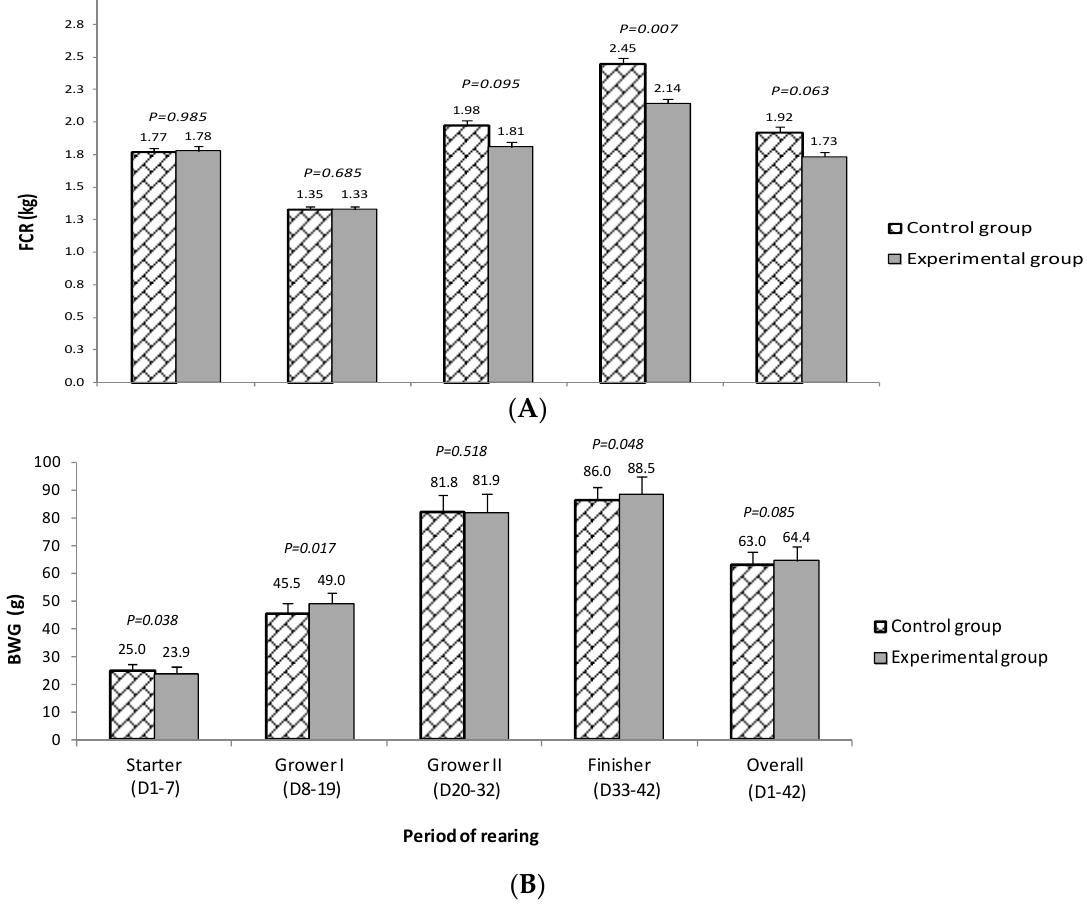
Figure 1. Feed conversion ratio (FCR ( A )) and average daily body weight gain (BWG, g/d; ( B )) of chickens fed complete mixtures without halloysite (control group) or with 1% of halloysite addition (experimental group).